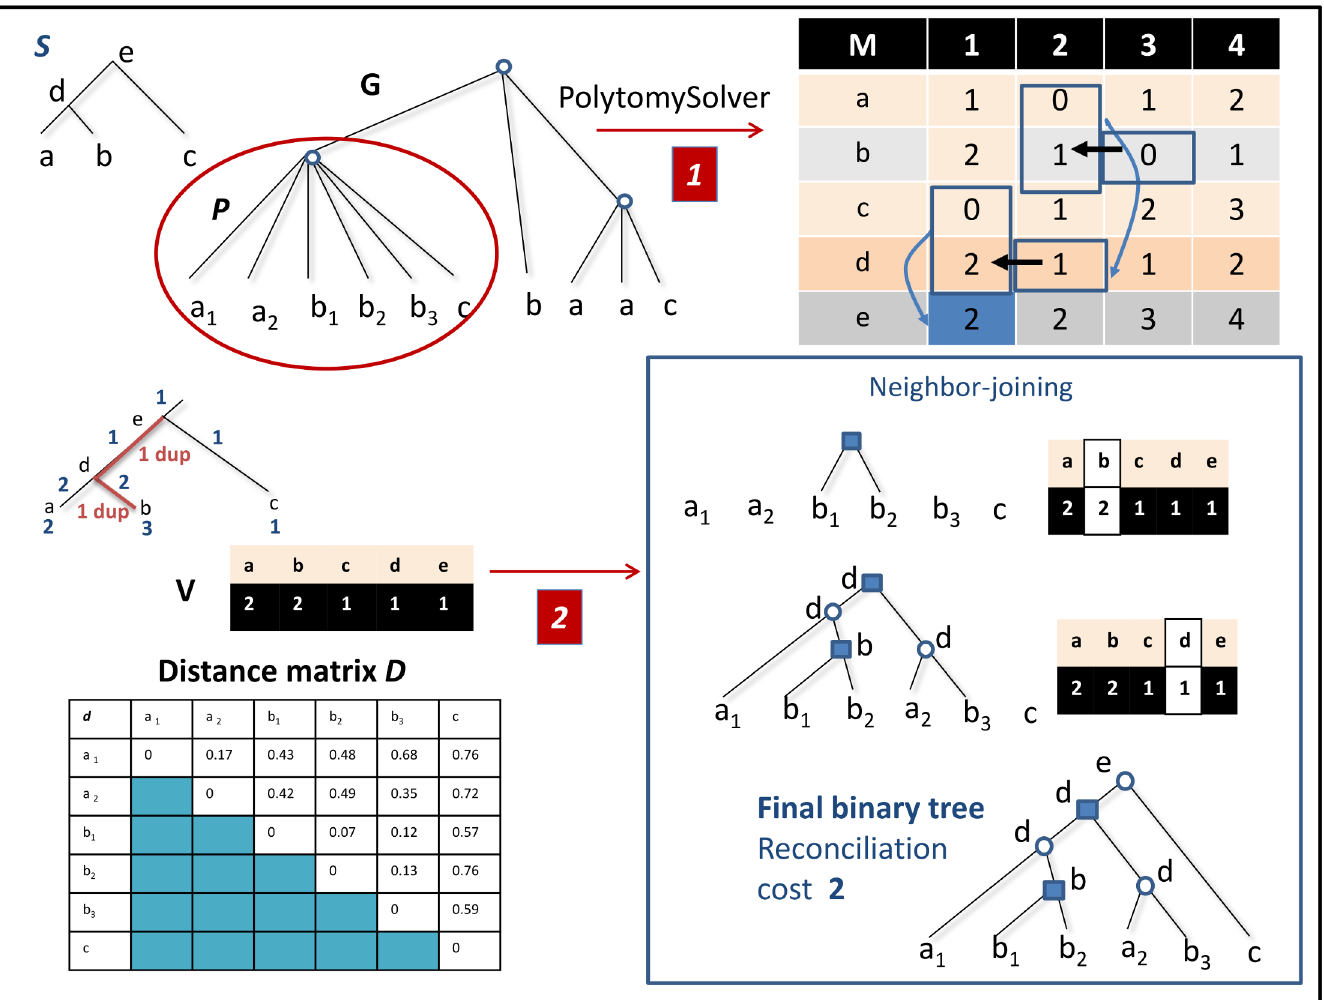
Fig 1. A species tree S and a multifurcated gene tree G . Each leaf x i or x of G represents a gene belonging to genome x present as a leaf in S . Step (1) of ProfileNJ is PolytomySolver, which resolves each polytomy P of G independently. A dynamic programming table M is constructed. Step (2) of ProfileNJ takes as input a count vector V , here resulting from the backtracking path related by rectangles and arrows in table M , and a distance matrix d for the considered genes. A Neighbor joining (NJ) based procedure computes the gene tree in agreement with V that best reflects the distance matrix. The final completely refined tree is given bottom right. Duplication nodes are indicated by